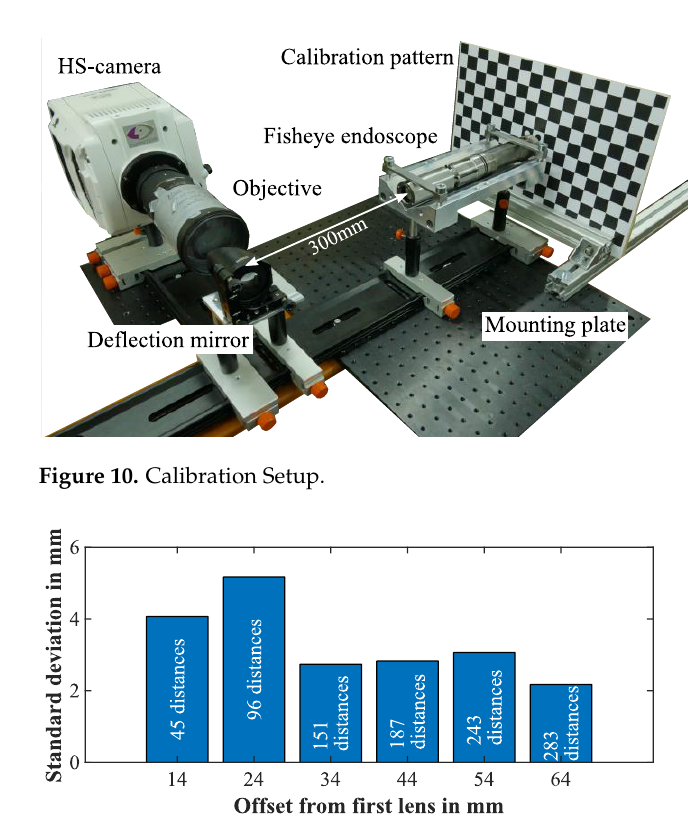
Figure 11. Standard deviation of distance between control points.